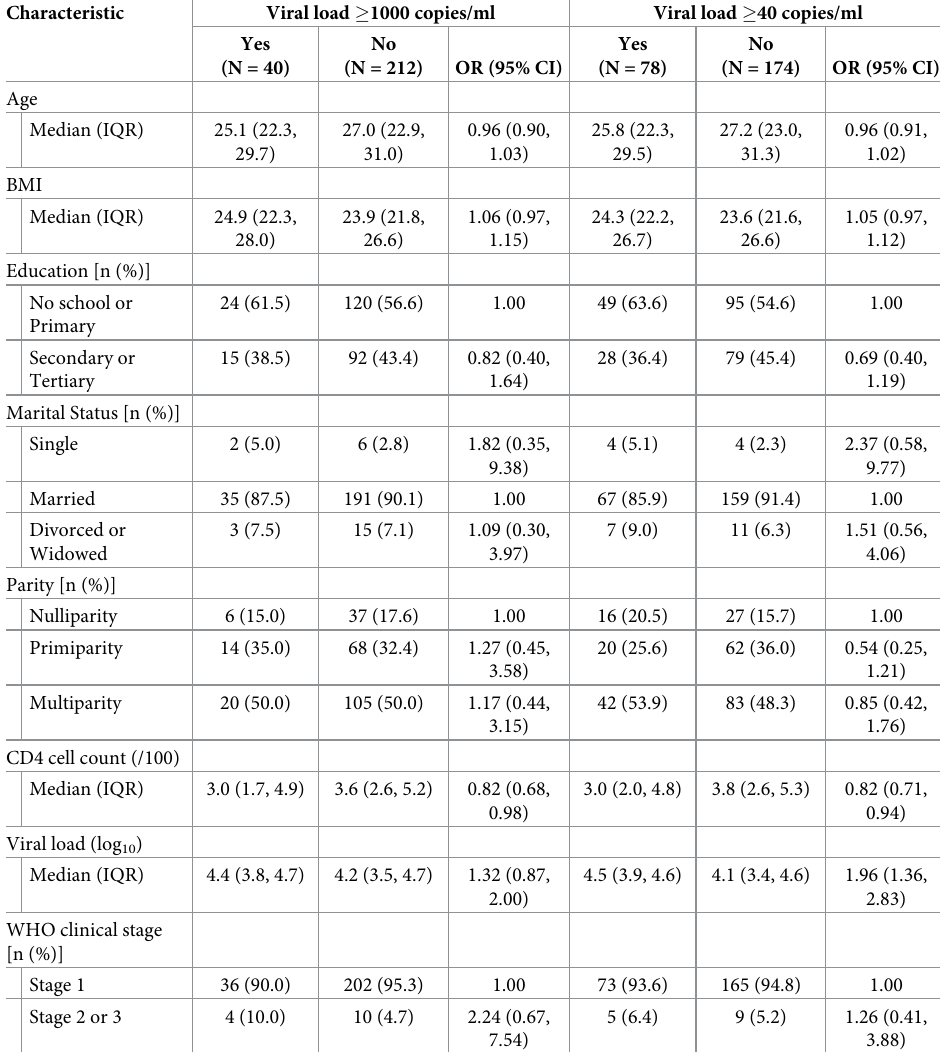
Table 2. Predictors of viral suppression at the time of delivery.